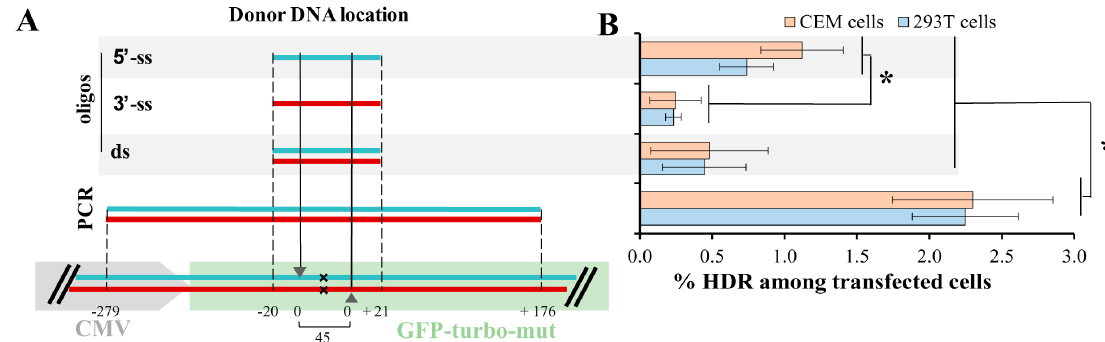
Figure 3. Knockin rates in 293T and CEM cells detected with different donor DNAs. ( A ) positioning single-strand (ss) and double-strand (ds) donor DNAs (flanked by dotted lines) relative to cleavage sites (shown by arrows) produced by Cas9 nickase in the mutated (x) gfp-turbo gene. The color of donor DNA strand (blue is coding and red is non-coding) matches the color of targeted gene strand; ( B ) the homology directed repair (HDR) rates in 293T-GFPt-mut and CEM-GFPt-mut cells were estimated at day 3 after transfection with plasmid DNAs encoding Cas9n, a pair of green fluorescent protein (GFP)-turbo specific gRNAs and indicated donor DNA. The proportion of GFP-positive (repaired) cells relative to all cells was normalized to the level of transfection, measured in each individual experiment. The results from at least three independent experiments are presented as average values with the standard deviations. * Data are statistically different at p <